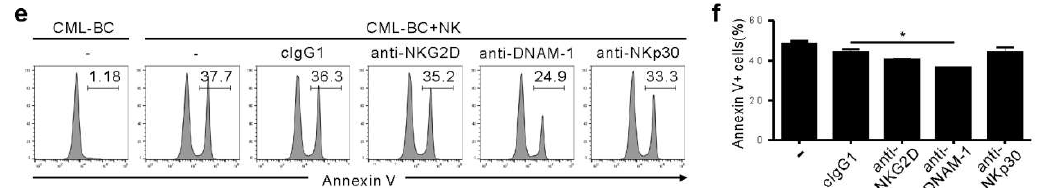
Figure 3. NK cells trigger cytolysis of primary CML-BC blasts, regardless of BCR-ABL1 mutation, in a DNAM-1-dependent manner. ( a ) Mononuclear cells (MNCs) from a CML-BC patient harboring BCR-ABL1 T315I were incubated with expanded primary NK cells for the indicated times. Apoptosis of CD34 + CML-BC cells in the absence or presence of NK cells in a 1:1 ratio was measured by annexin V-FITC and CD34-PE staining. The representative percent apoptosis of CD34 + CML-BC cells is presented as the result of two independent experiments. ( b ) MNCs from a CML-BC patient harboring di ff erent BCR-ABL1 mutations ( n = 5) were incubated with expanded primary NK cells for the indicated times. Apoptosis of CD34 + CML-BC cells in the absence (dotted line) or presence (solid line) of NK cells was measured as in ( a ). The percent apoptosis of CD34 + CML-BC cells is shown as a line graph. ( c ) Representative flow cytometric profiles showing the surface expression of NKG2D ligand (MICA / B, ULBP1, ULBP2 / 5 / 6, and ULBP3), DNAM-1 ligand (PVR and Nectin-2), or NKp30 ligand (B7-H6) on gated CD34 + CML-BC cells (red histogram). The representative mean fluorescence intensity (MFI) of each ligand in the histogram is presented as the result of two independent experiments. ( d ) The MFI of the expression of each indicated ligand on gated CD34 + CML-BC cells ( n = 5) is shown. Horizontal bars indicated the medians. ( e , f ) MNCs from a CML-BC patient were incubated with expanded primary NK cells preincubated with mAb to the indicated receptors (20 µ g / mL) for 2 h. Apoptosis of CD34 + CML-BC cells was measured as in ( a ). Shown are representative flow cytometry profiles ( e ) and a graph of statistical bar charts ( f ), demonstrating the percentage of apoptotic CD34 + CML-BC cells. The mean values ± s.d. of two independent experiments are shown. * p < 0.05 by Student’s t